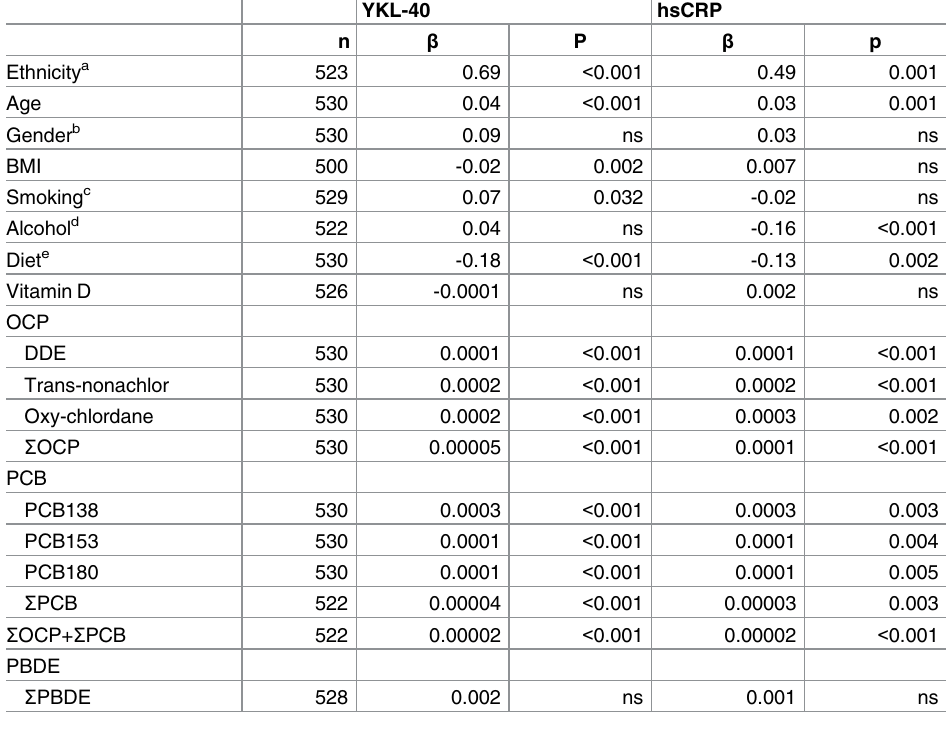
Table 5. Factors important to YKL-40 and hsCRP among populations in Greenland participating in the survey in univariate linear regression